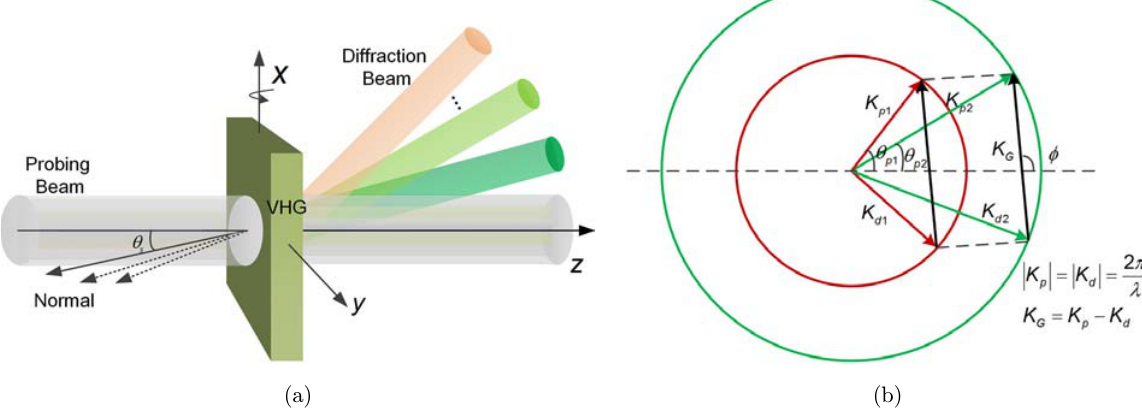
Fig. 2. (a) Schematic for illuminating VHG with collimated beam consisting of multiple wavelengths. The wavelength changes of the di®raction beam correspond to the angles between the normal vector of the VHG and the z -axis. The dash normal vectors indicate that the VHG is in di®erent rotation positions around x -axis. (b) The K-sphere diagram for grating recording geometry with one wavelength (green) and probed by another wavelength (red). Note that small rotations around x -axis should be applied to the VHG to match Bragg condition for di®erent wavelengths. (cid:4) p 1 and (cid:3) p 1 represent the incident angle and wavelength of probing beam, respectively, (cid:4) p 2 and (cid:3) p 2 represent the incident angle and wavelength of signal beam in recording geometry, respectively. (cid:5) is the inclination of K-vector of holographic grating with respect to its corresponding hologram normal. K p ; K d , and K G represent the K-vector of probe beam, di®raction beam, and holographic grating, respectively.